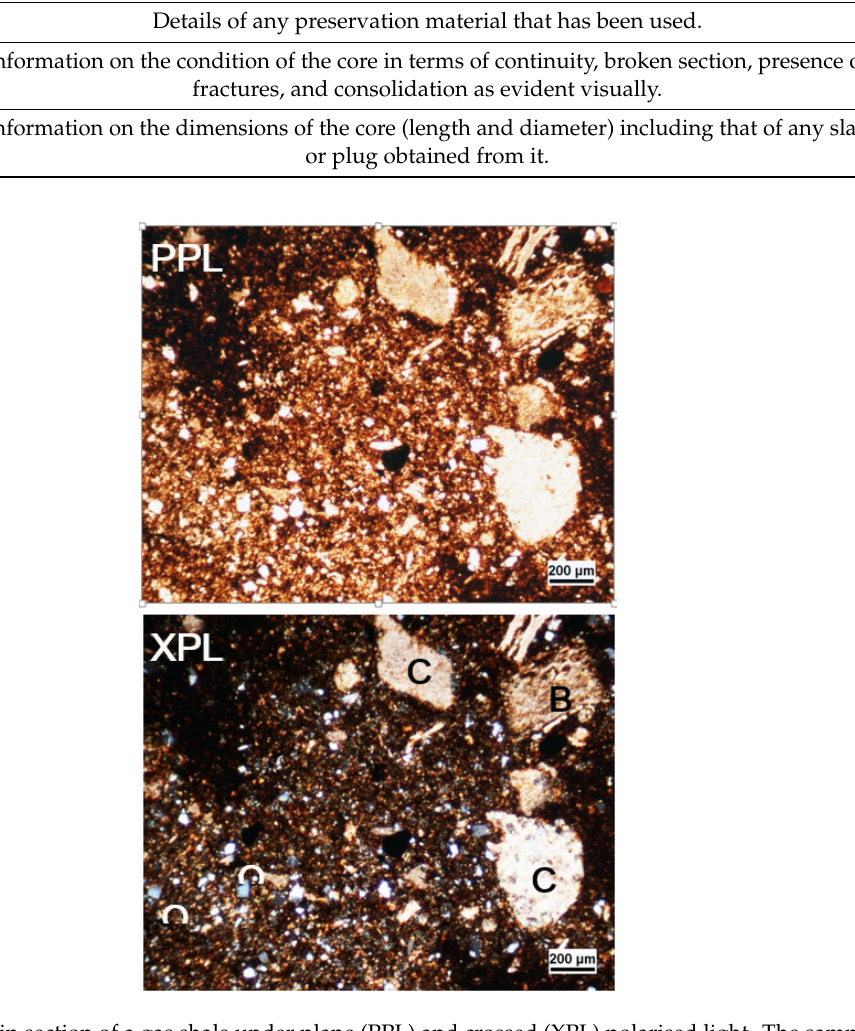
Figure 2. Thin section of a gas shale under plane (PPL) and crossed (XPL) polarised light. The sample belong to a core from the Bossier–Haynesville formation of East Texas Basin of Jurassic age (156 to 145.5 Ma) corresponding to a depth of 3616 m. It is composed mostly of mud particles (55 modal %) and therefore unconsolidated, with angular and moderately sorted detrital quartz grains (Q) of average size 0.1–0.5 mm and bioclasts (crinoids: C and bryozoan: B) of average size 0.2 mm (35 modal %) with a small amount of matrix and cement (10 modal %). Table 2. The essential background information required for any core to be used for scientific analyses. No.